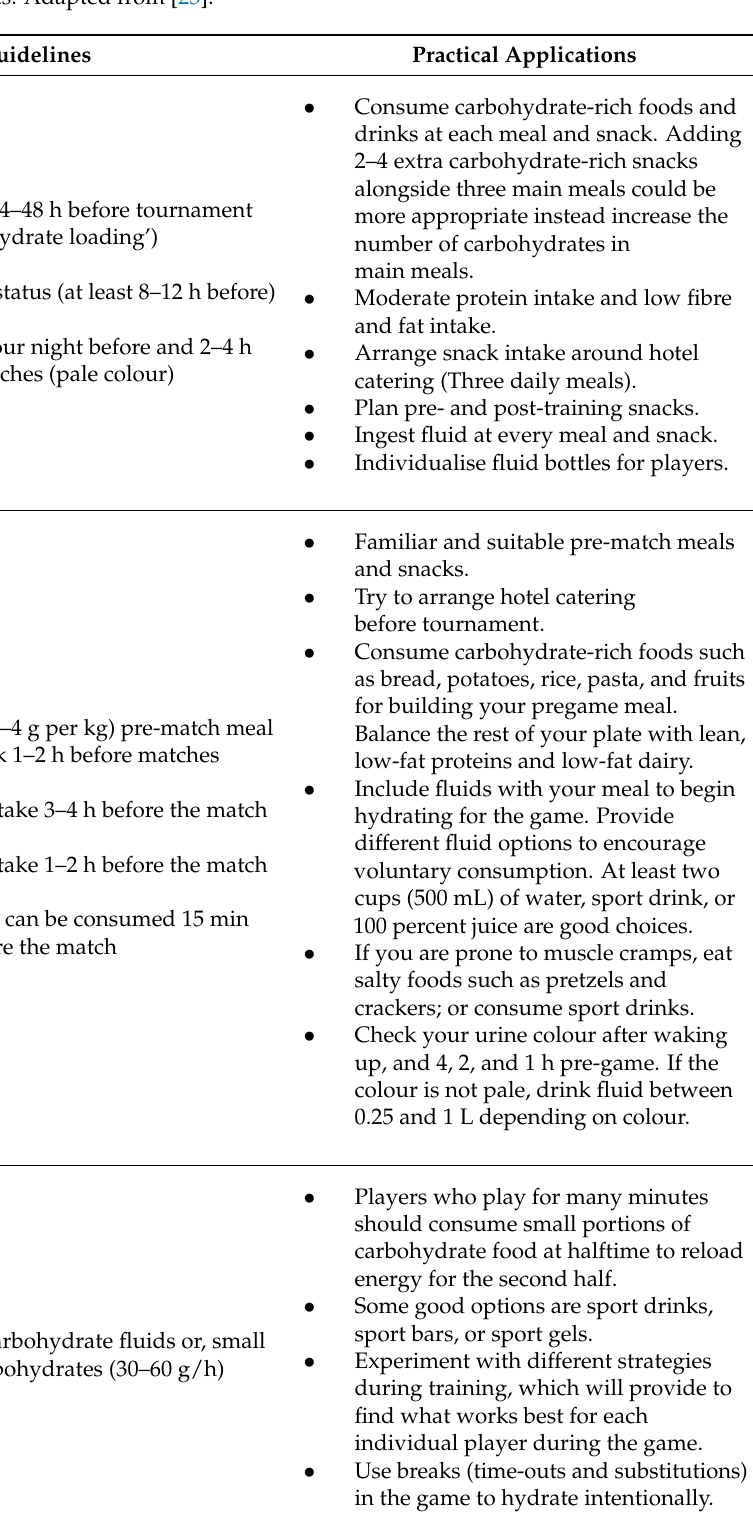
Table 1. Practical nutrition strategies for optimum performance during international short-term basketball tournaments. Adapted from